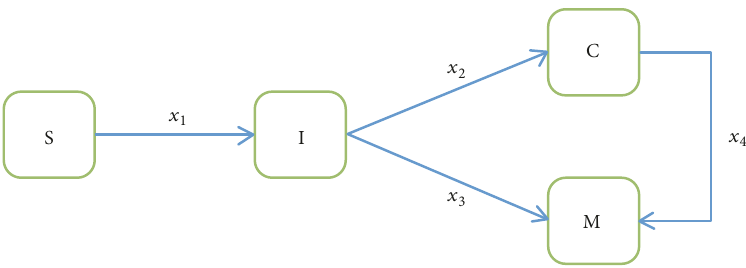
Figure 1: The process of risk contagion based on SICM